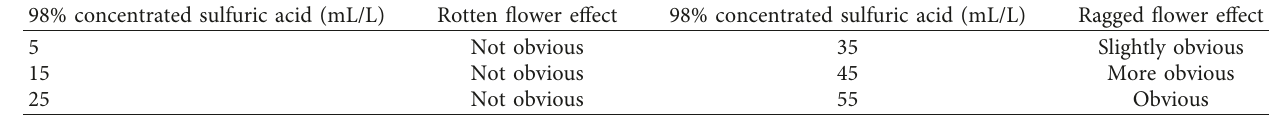
Table 1: Effect of sulfuric acid concentration on burnt-out effect.